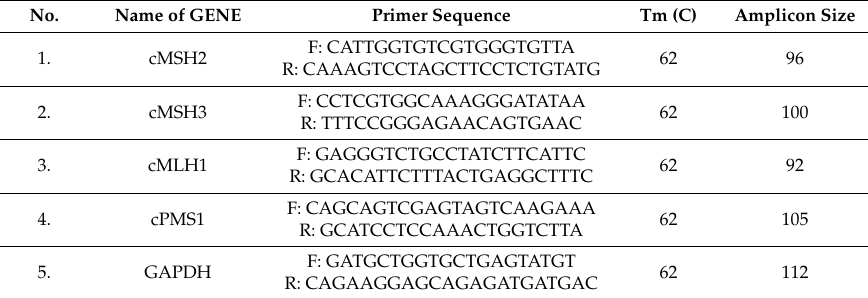
Table 2. Primer used for real time